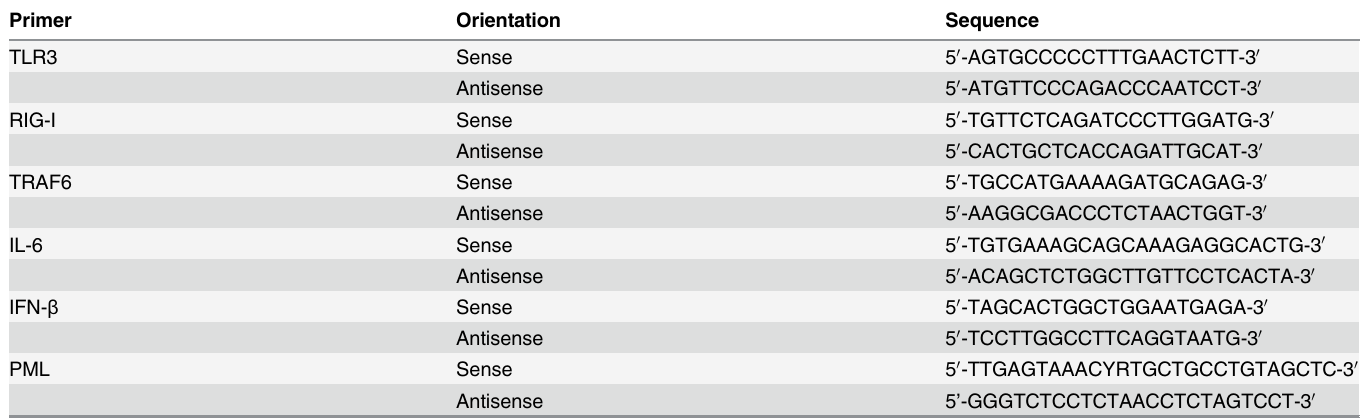
Table 1. Primer sequences used for real-time RT-PCR